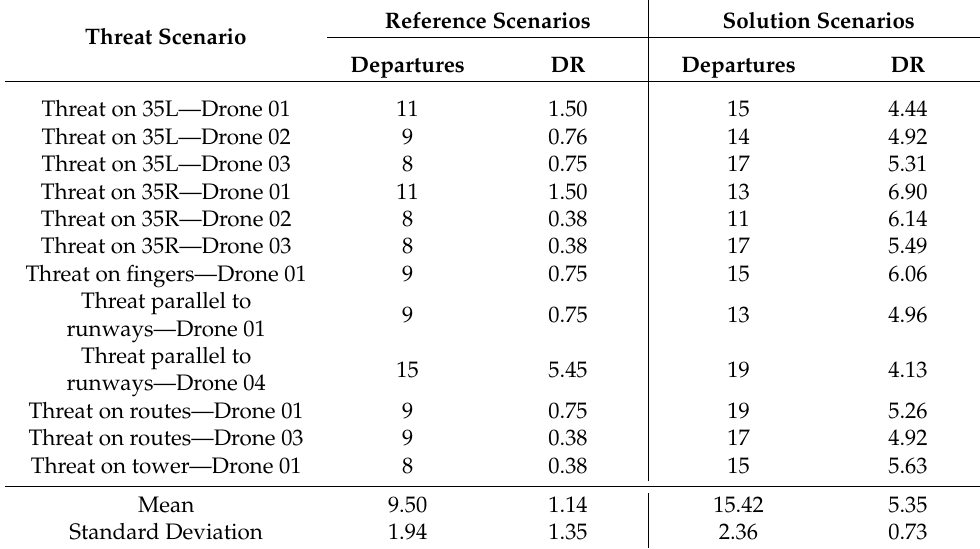
Table A5. Simulation results: capacity